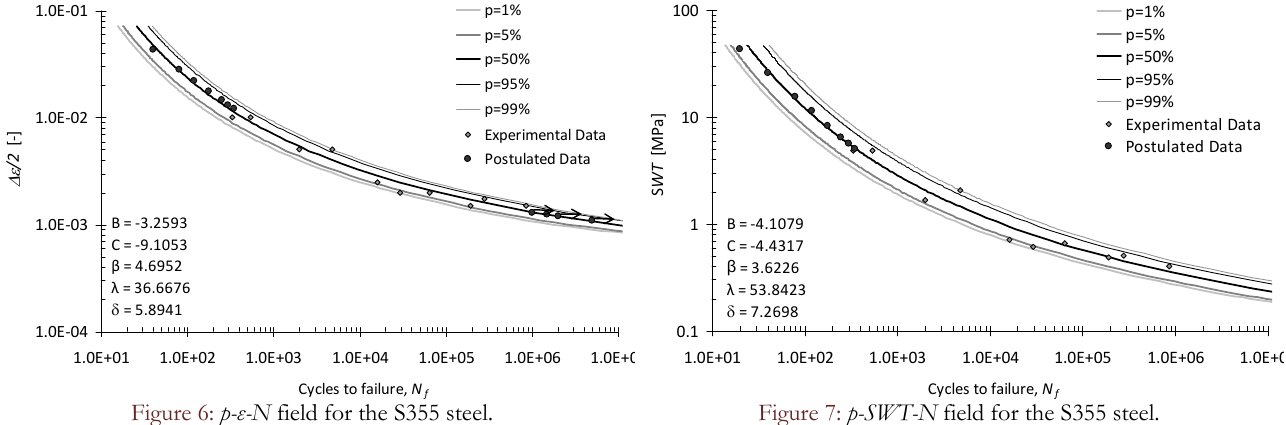
Figure 5: Experimental fatigue crack propagation data of the S355 steel for distinct stress ratios: experimental results.